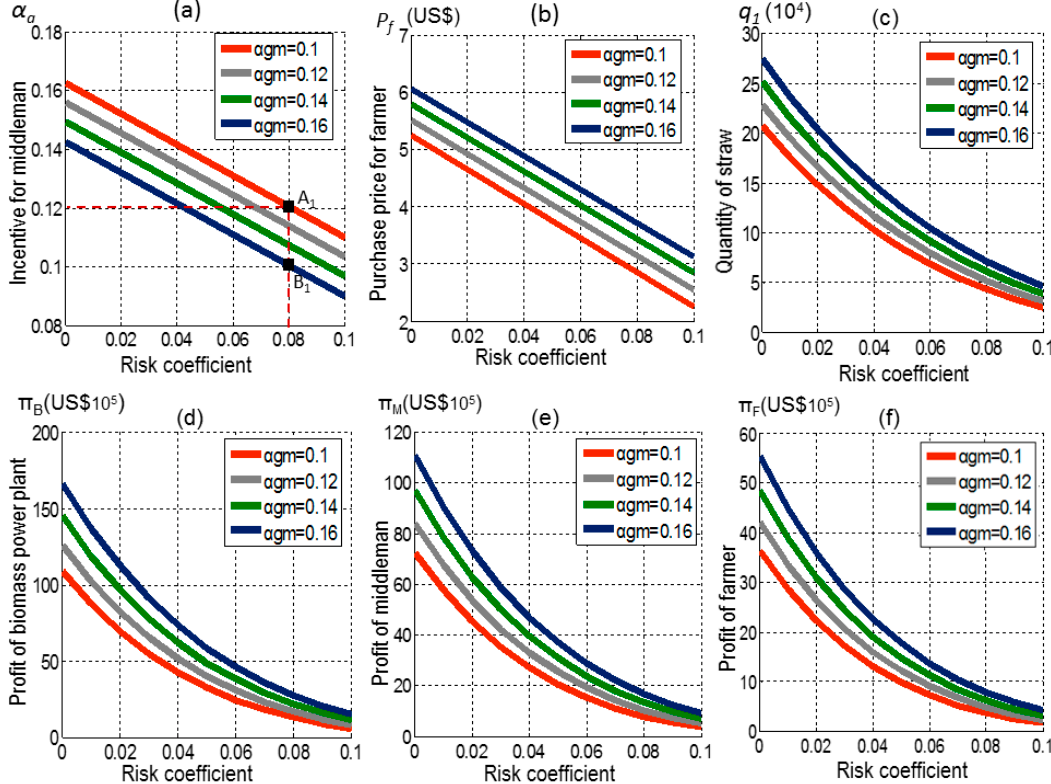
Figure 6. α a , p f , q 1 and changes of profitsunder risk perception in incentive for the middleman situation. ( a ) Description of α a change; ( b ) Description of p f change; ( c ) Description of q 1 change; ( d ) Description of profit change of biomass power plant; ( e ) Description of profit change of middleman; ( f ) Description of profit change of